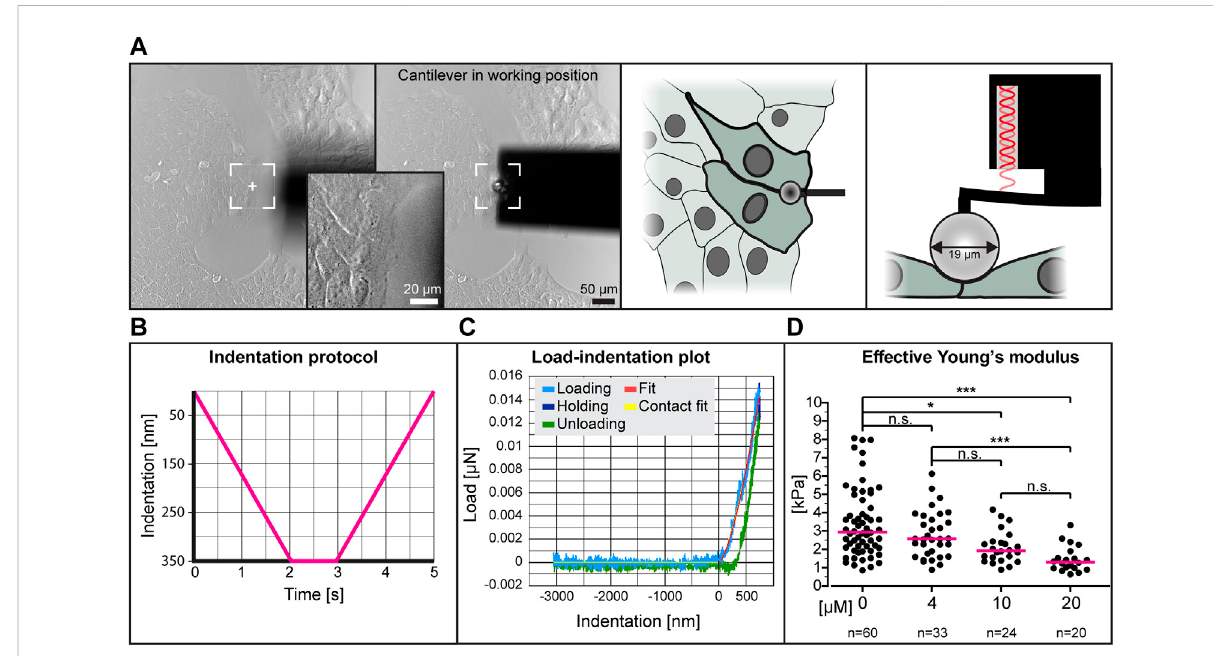
FIGURE 2 The effective Young ’ s modulus of HaCaT cells decreases with increased dose of para-nitro-blebbistatin. The Young ’ s modulus was measured with the help of a nanoindenter. (A) presents bright- fi eld images at left depicting the cantilever in relation to the cells before positioning and during indentation.Notethatthecantileverisplacedattheborderbetween2 cellsattheperipheryofacellcolony.Theschemesatrightfurtherillustratethe positioningofthecantileverfromthetopandtheside,respectively. (B) Thegraphillustratestheindentationprotocolconsistingofa2 s350 nm indentation, 1 s holding and 2 s retraction. (C) The graph shows an exemplary load-indentation curve encompassing a loading (light blue), holding (darkblue)andunloadingpart(green).TocalculatetheYoung ’ smodulus,theHertzianmodelusesthe fi ttedloadingcurve(red)andthecontactpoint (yellow). (D) The scatter dot plot shows theeffective Young ’ s moduli for cells treated with 0, 4, 10 and 20 µM para-nitro-blebbistatin for 30 – 90 min. Theplotwasgeneratedbycombiningthemedianspercondition.Kruskal – Wallistestissigni fi cantwitha p < 0.0001andDunn ’ smultiplecomparison post-test shows signi fi cant differences as indicated in the graph (* p < 0.05, *** p <